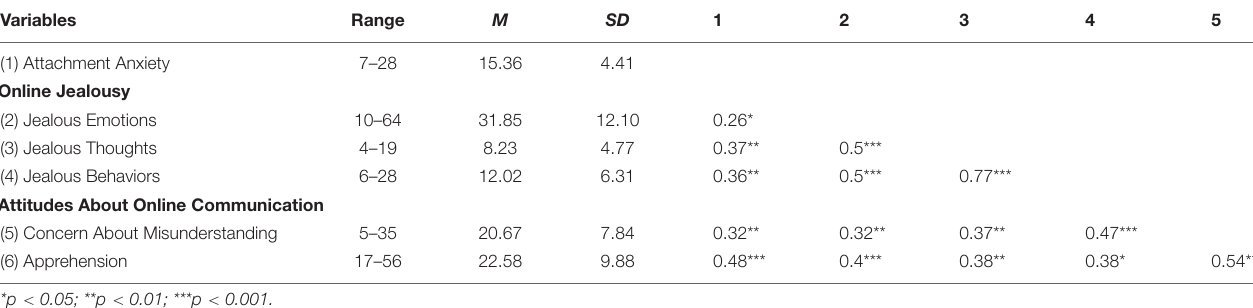
TABLE 1 | Descriptive statistics and correlations among all variables.